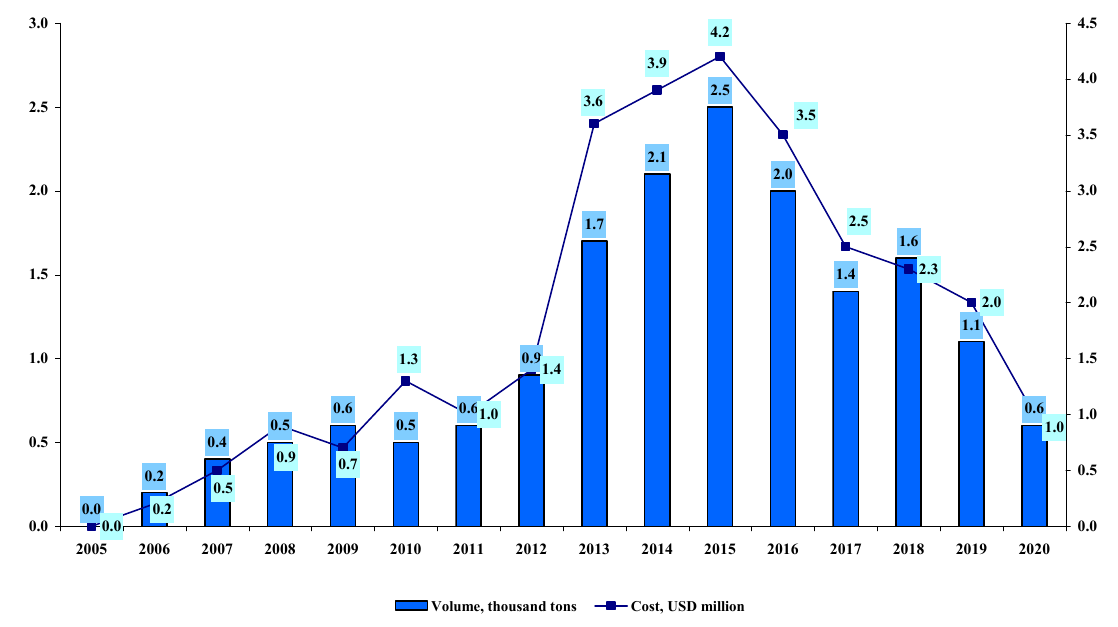
Figure 3. Dynamics of imports of soy seeds, USD without VAT. Source: State Statistics Service of Ukraine.